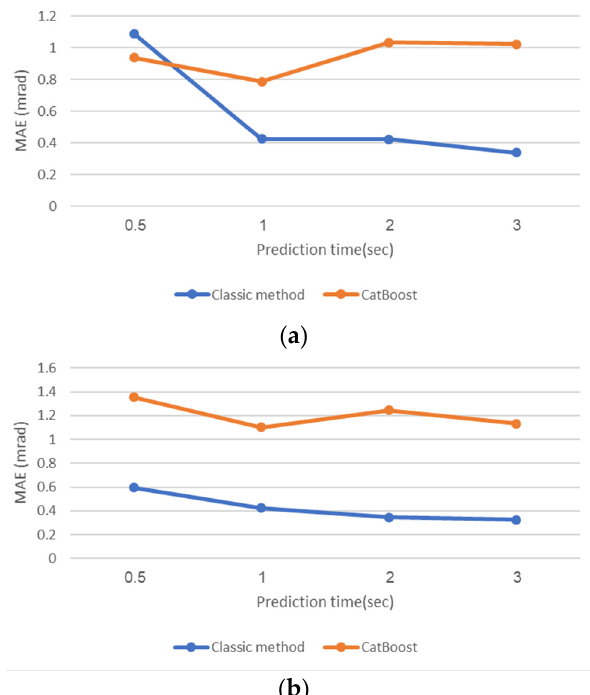
Figure 7. Wide range error values using CatBoost CA vs. classical CA. ( a ) Roll error; ( b ) Pitch error.